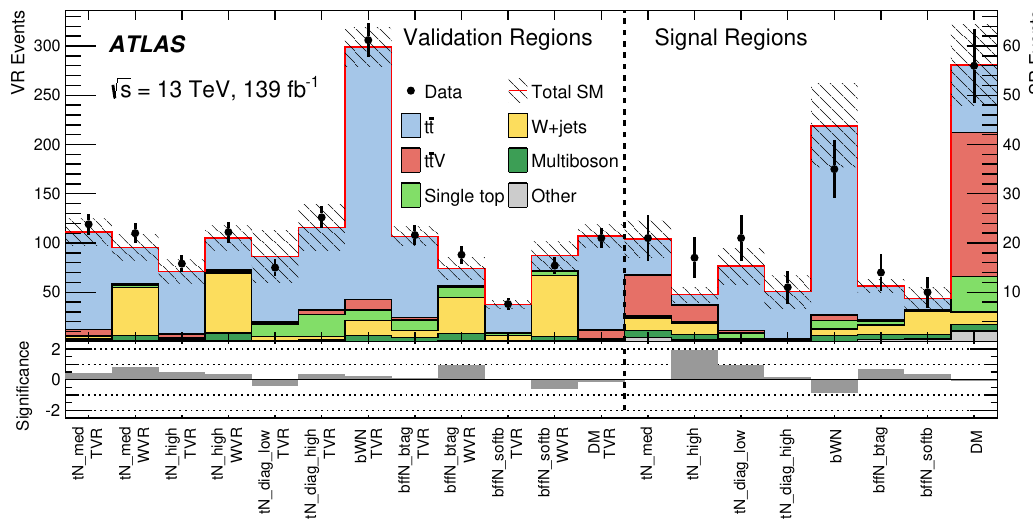
Figure 10. The upper panel shows the comparison between the observed data ( n obs ) and the predicted SM background ( n exp ) in all VRs and SRs. The background predictions are obtained using the background-only fit, and the hatched area around the SM prediction includes all uncertainties. The bottom panel shows the Z significance of the observed number of events given the SM